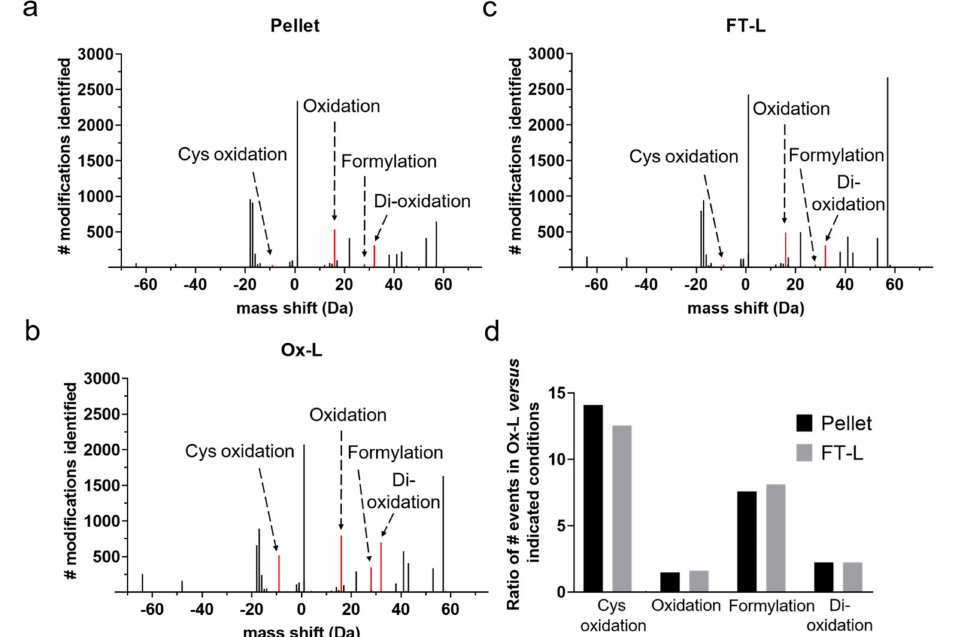
Figure 1. HOCl induces protein oxidation in cancer cells, in vitro. MaxQuant dependent peptide search results of proteomics analysis of A375 melanoma tumor cells that were incubated for 1 h in the presence ( a ) or absence ( b ) of 60 µ M HOCl, washed and subjected to 6x freeze-thaw cycles, or left untouched after harvesting ( c ) The average number of mass shifts events compared to the unmodified peptides identified across technical replicates ( n = 4) were reported; red lines represent the indicated specific modifications that increased significantly upon HOCl treatment. ( d ) Bar graph reporting the ratio of modifications identified in Ox-L over the indicated